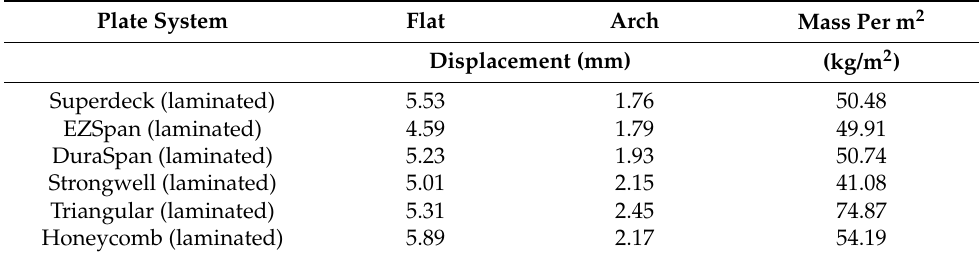
Table 3. Results for composite layup (0/90/0/90) plate